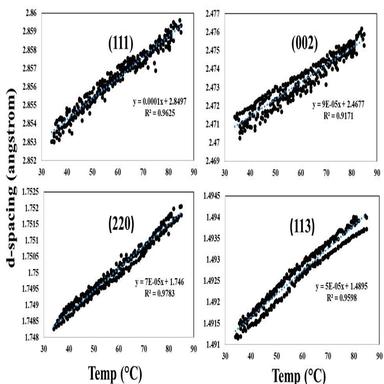
Fitted peak position vs. temperature for the Pb-Bi (111), (002), (220), and (113) reflections after one thermal cycle.